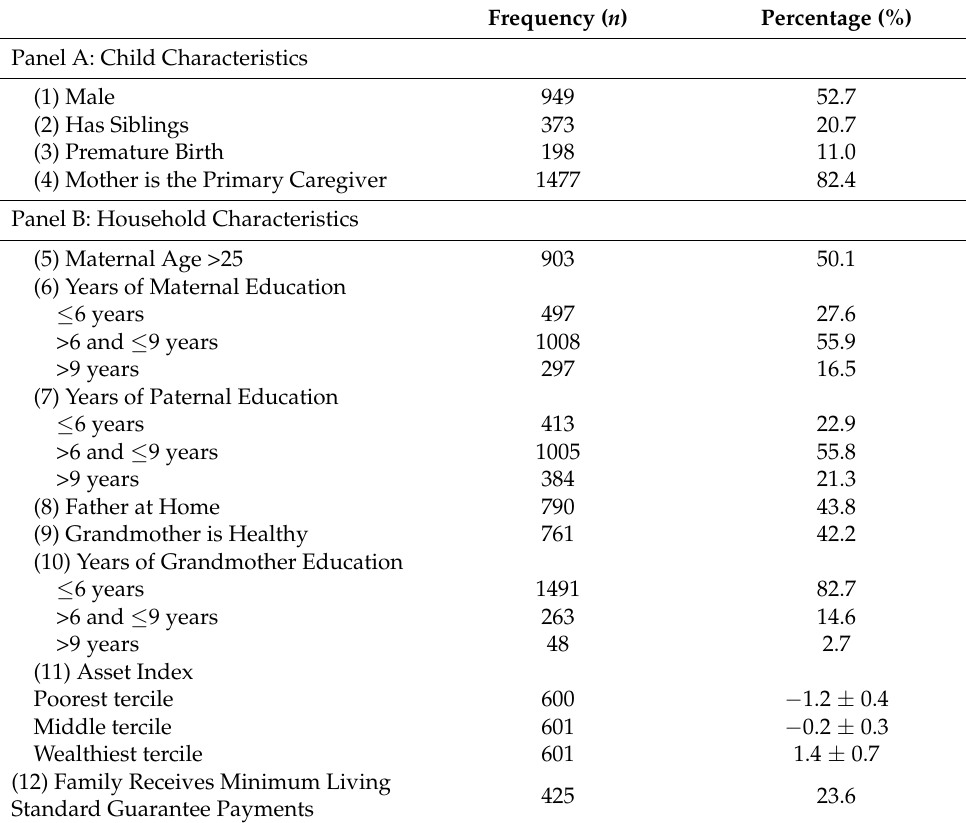
Table 1. Summary statistics of sample children aged 6–12 months in rural China ( n =